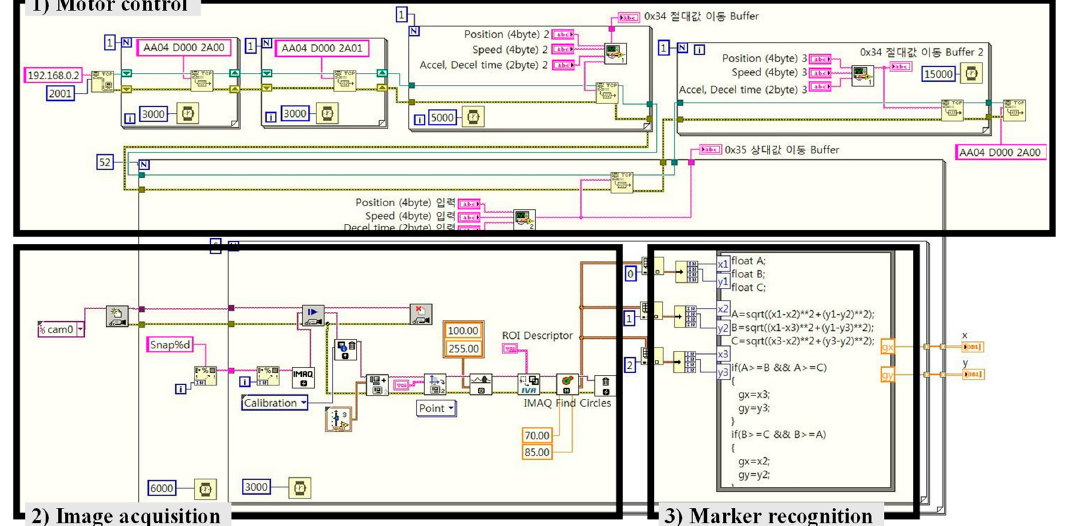
Figure 13. LabVIEW code for the look-then-move process.